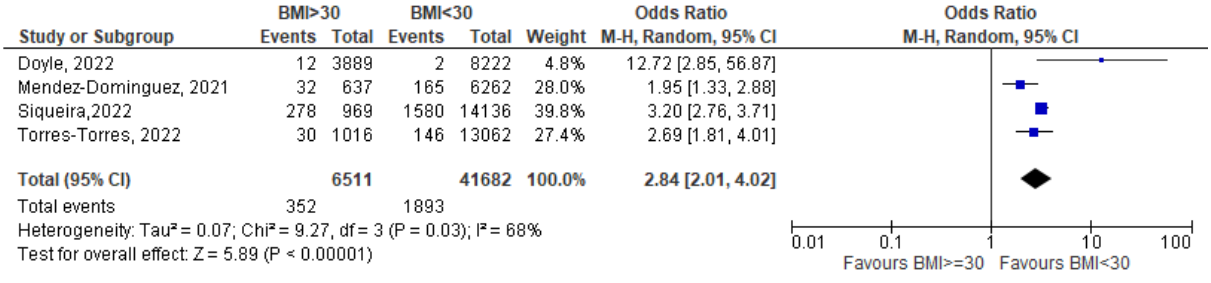
Figure 3. BMI >= 30 vs. BMI < 30—maternal death due to COVID-19-related causes) [23–26]. Hospital admissions for COVID-19-related causes